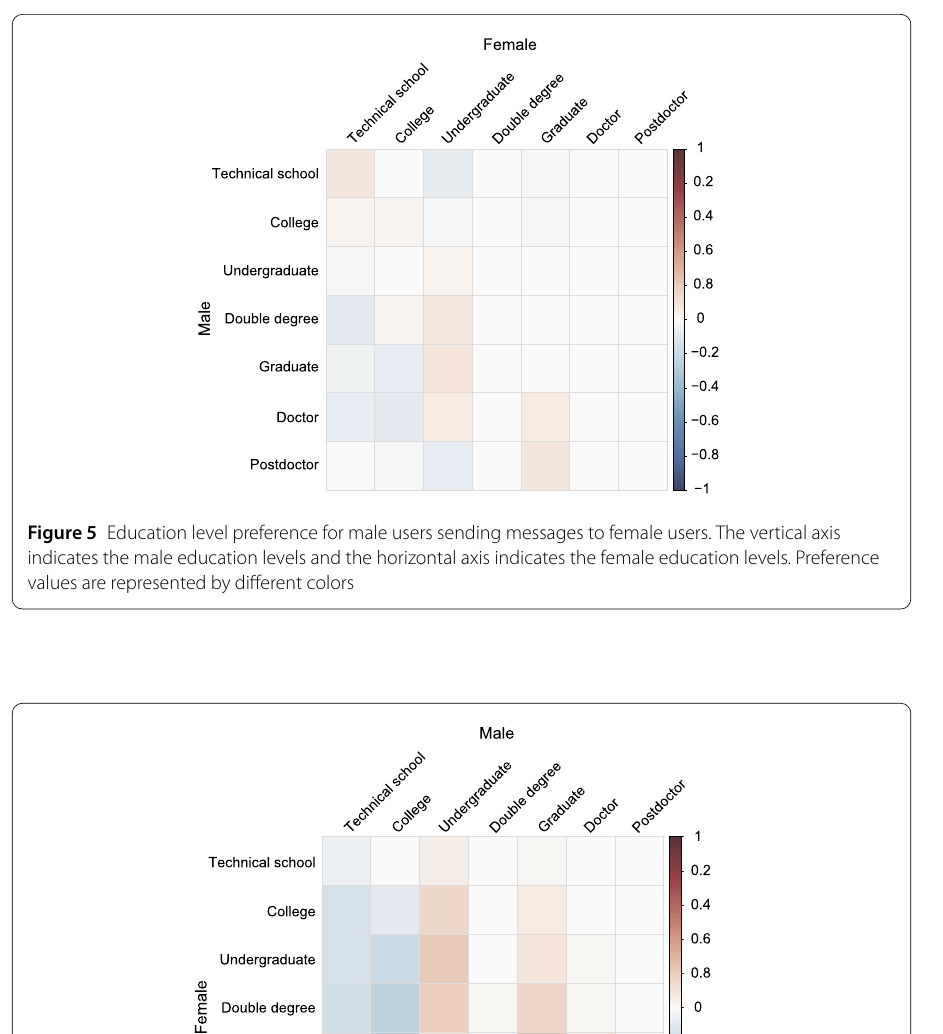
men who earn RMB 10,000 to RMB 20,000 are the most popular. In terms of preference for income levels, generally women also show potentials-attract characteristic. A field ex- periment on a Chinese online dating site found that men visited the profiles of women of different incomes with roughly the same rates, while for women, the higher the male incomes are, the greater the rates of visiting their profiles will be [38], which is different from our